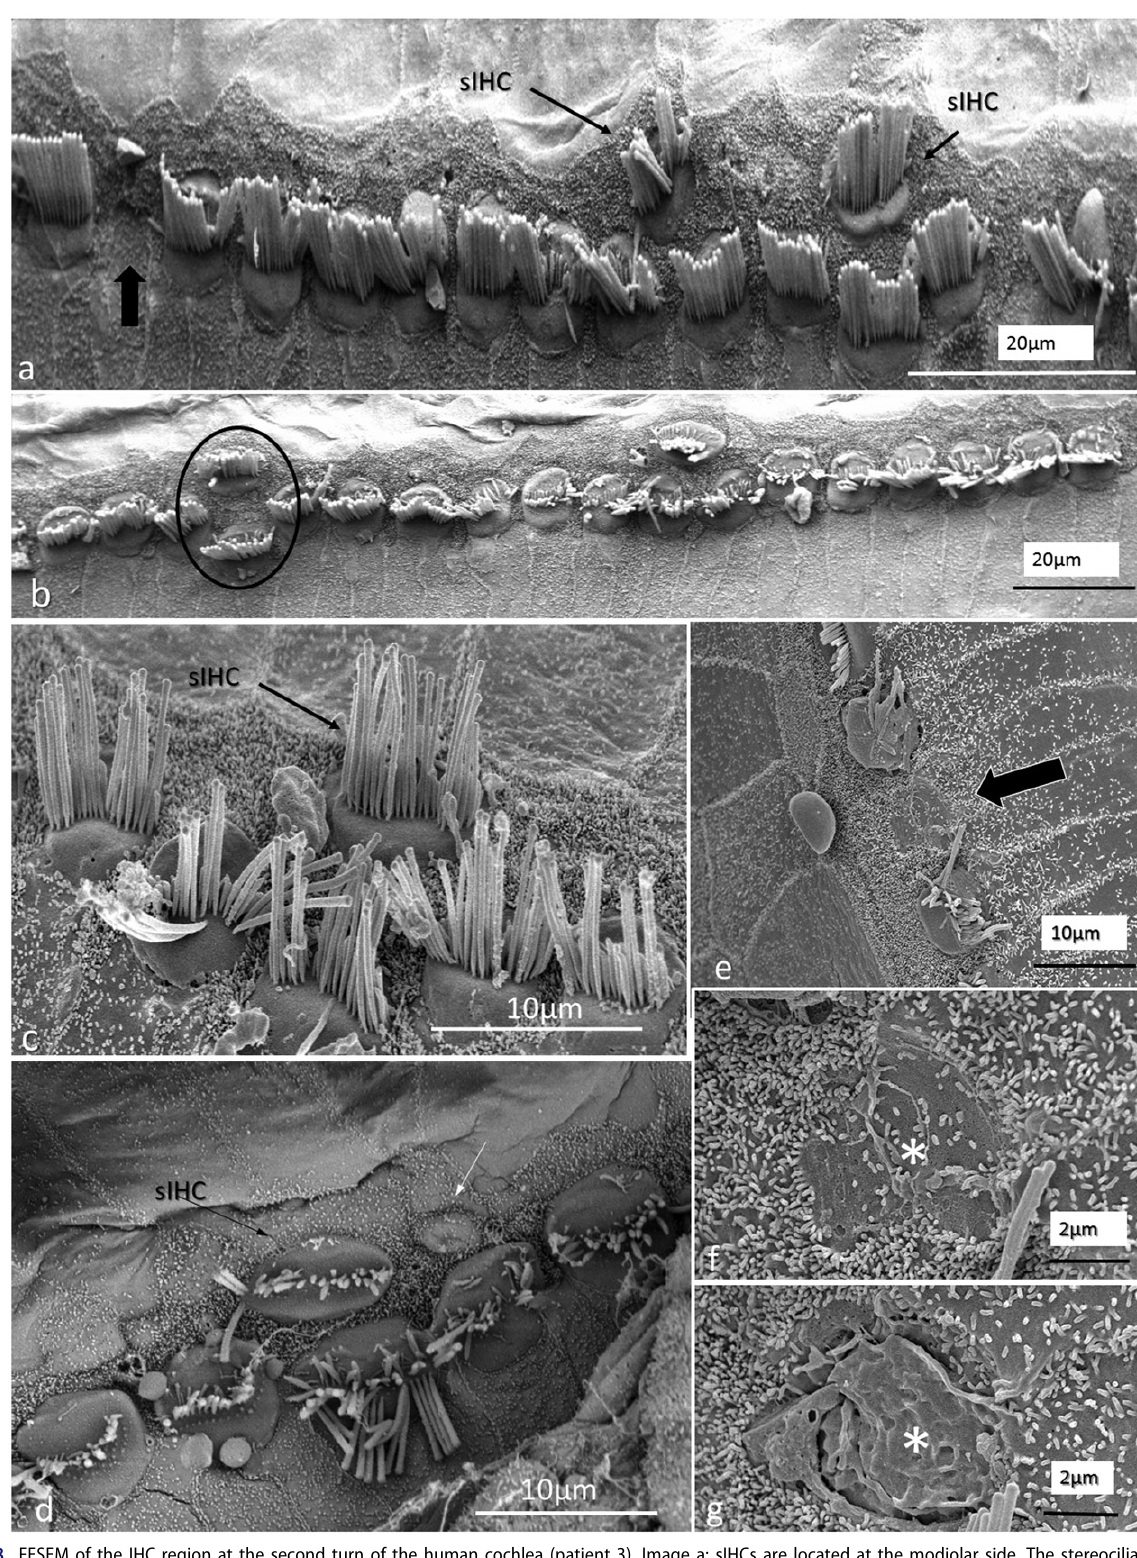
Figure 8. FESEM of the IHC region at the second turn of the human cochlea (patient 3). Image a: sIHCs are located at the modiolar side. The stereocilia bundle of the left sIHC is not well aligned and forms an angle of almost 90 (cid:4) with the IHC row. The surface of the bordering cells is rich in microvilli, whereas the surface of the inner sulcus cells is smooth. One IHC is apparently missing (filled arrow). Image b: At one site (encircled), two parallel hair cells are present. Image c: A sIHC in the upper region of the second turn. The lengths of the longest stereocilia vary. Image d: The IHC region of the lower second turn. A sIHC can be observed. A bulg- ing border cell is present on the right of the sIHC. Image e: Three degenerated IHCs are present in this region. The center cell (arrow) is replaced with a supporting cell. Image f: Higher magnification of center cell (asterisk) shown in Image e. Image g: The lost IHC is replaced with a cell process from the adjacent supporting